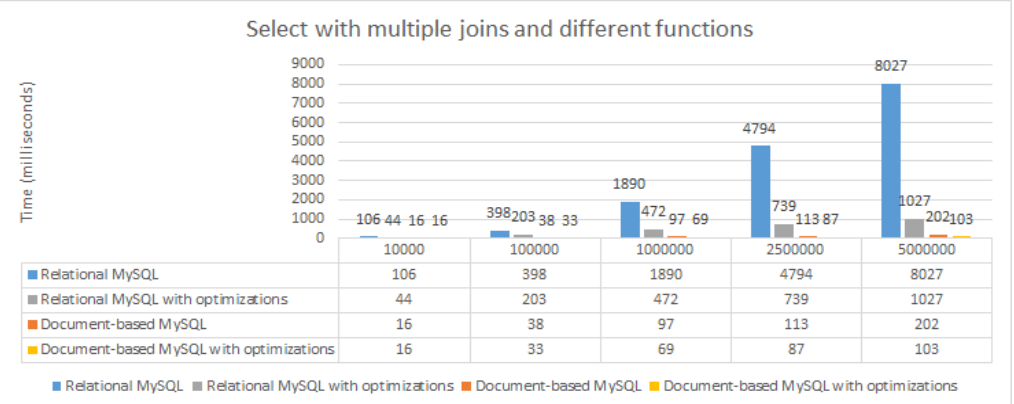
Figure 11. Performance time (ms) for select operation with multiple joins and functions.